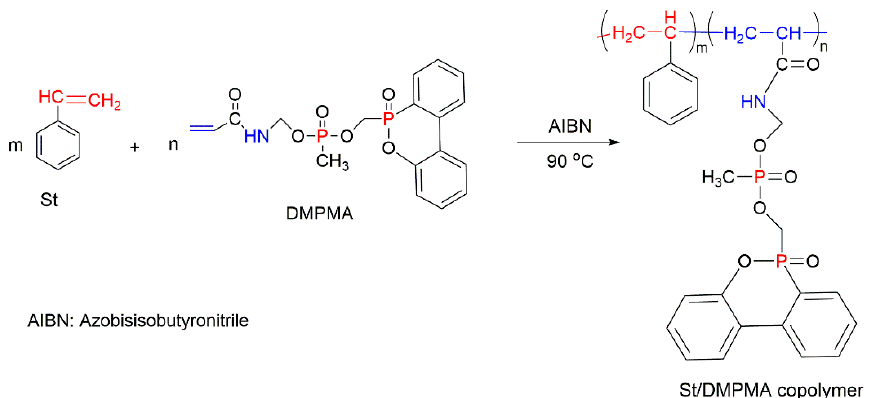
Figure 24. Copolymerisation of St with 2-[(6-oxido-6H-dibenzo[c,e][1,2]oxaphosphinin-6-yl)-methoxy]methyl phosphate N-methyl acrylamide (DMPMA) initiated by azobisisobutyronitrile (AIBN) [48].